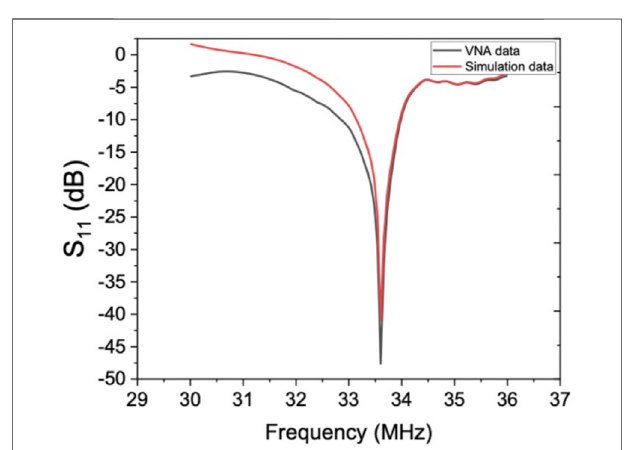
FIGURE 4 | Comparison of the frequency response results from numerical simulation and experimental data for experiment number